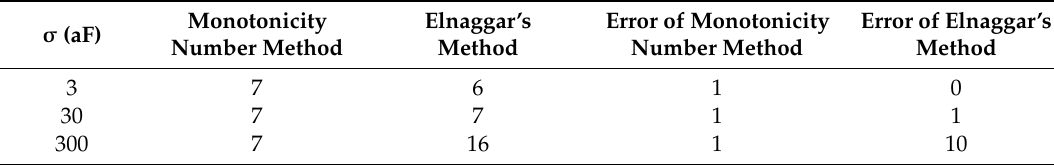
Table 3. E ff ect of measurement noise on dead time estimation. Table 3. Effect of measurement noise on dead time estimation